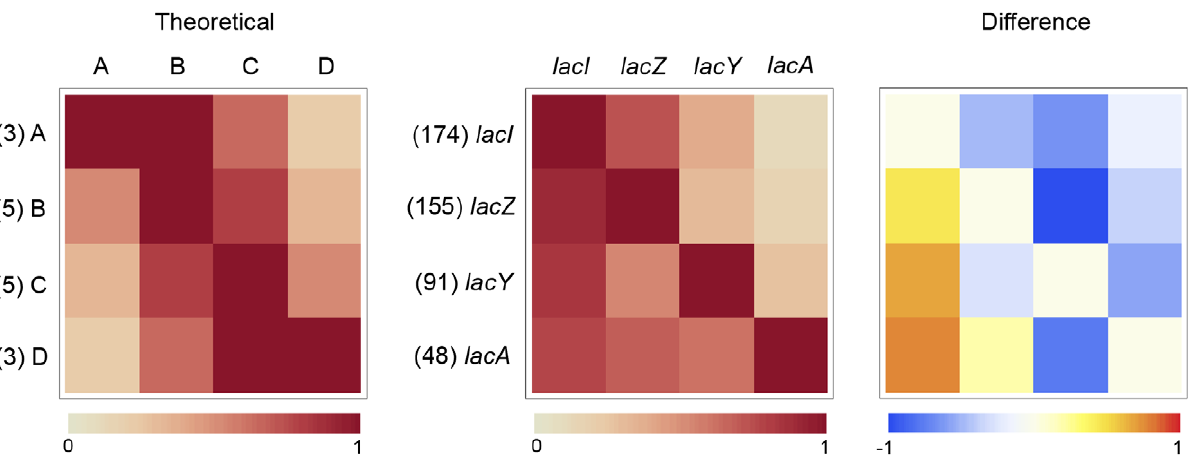
Figure 4. Coincidence heat map for Lac operon LMNAST stringent search hits. Each shaded index represents the normalized frequency of hits containing the row gene that also contain the column gene out of the total number of hits containing the row gene, as denoted by ( # ). The matrix on the left is a representation of an unbiased set of evenly distributed homologs (AB, BC, CD, ABC, BCD, and ABCD). The middle matrix is the actual coincidence data. The matrix on the right is a heat map of the difference between the two. LacI is heavily over-represented according to the difference matrix. LacY occurred less than would be expected according to a random distribution.